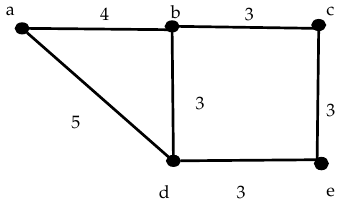
Figure 2. 5-node network